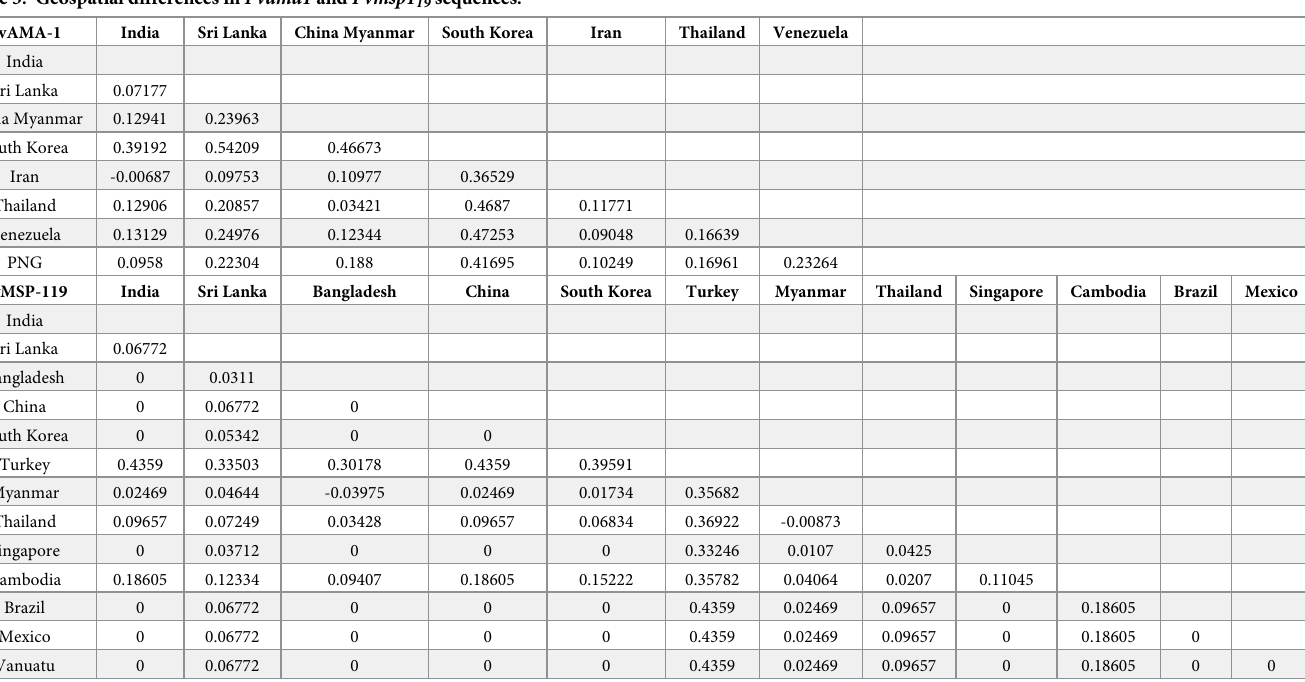
Table 3. Geospatial differences in Pvama1 and Pvmsp1 19